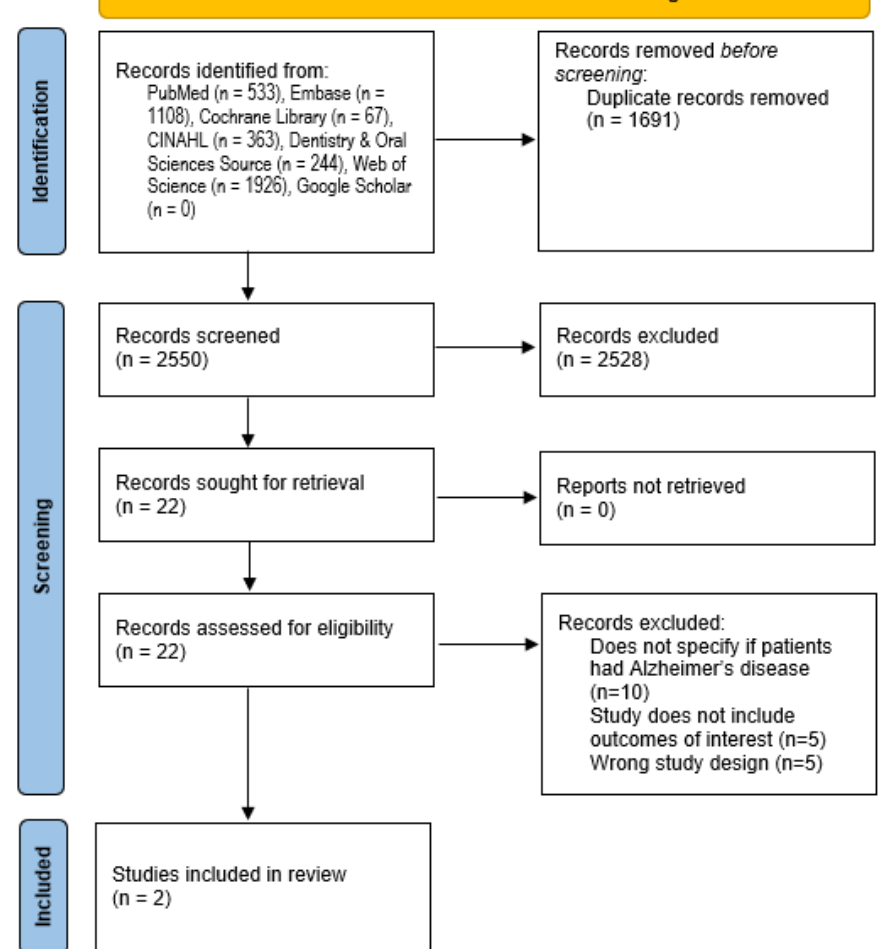
Figure 1. PRISMA 2020 flow diagram of the study selection process [15].